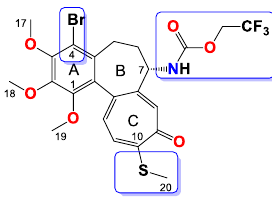
Figure 8. Structure of compound 8 .